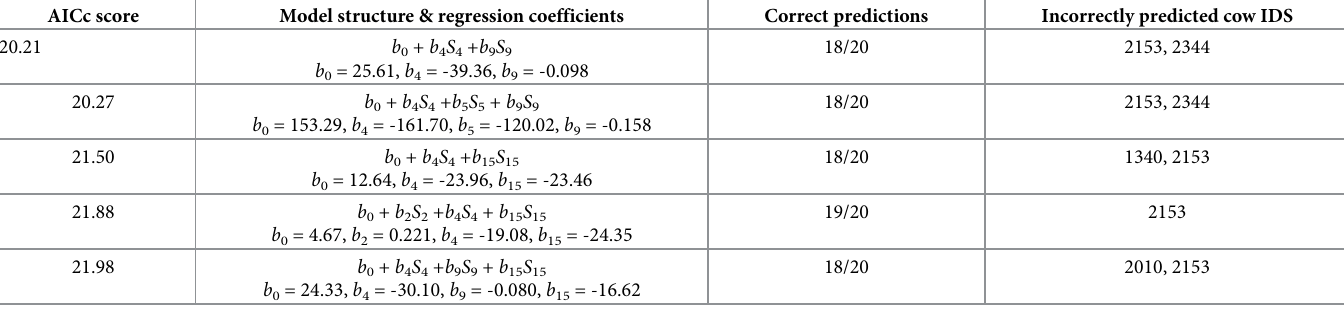
Table 2. Best fitting model structures considered for logistic regression predictive model with associated Akaike Information Criterion (AICc) scores (corrected for small sample sizes).